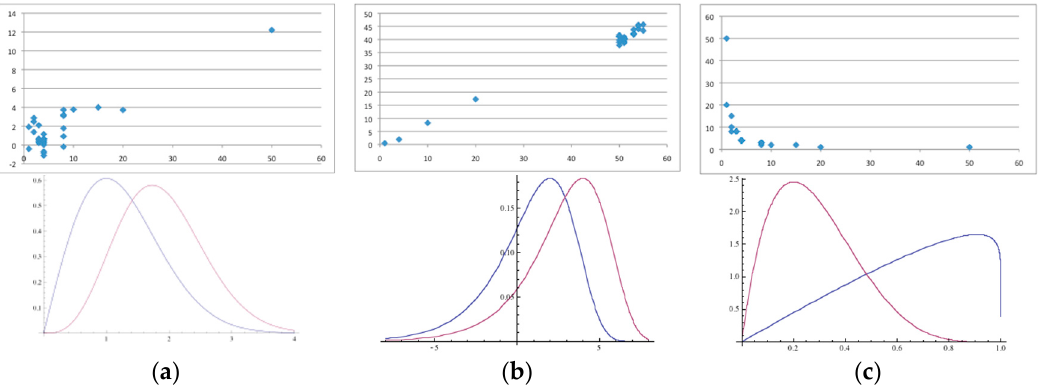
Figure 1. Various types of co-skewness: ( a ) positive left-tail co-skewness; ( b ) positive right-tail co-skewness; ( c ) negative co-skewness. Scatter diagrams (upper pane); probability density functions (lower panel).